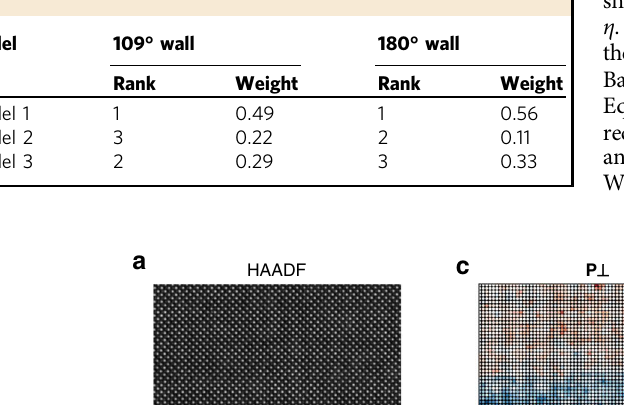
Table 2 WAIC model comparison for the 109° and 180° domain